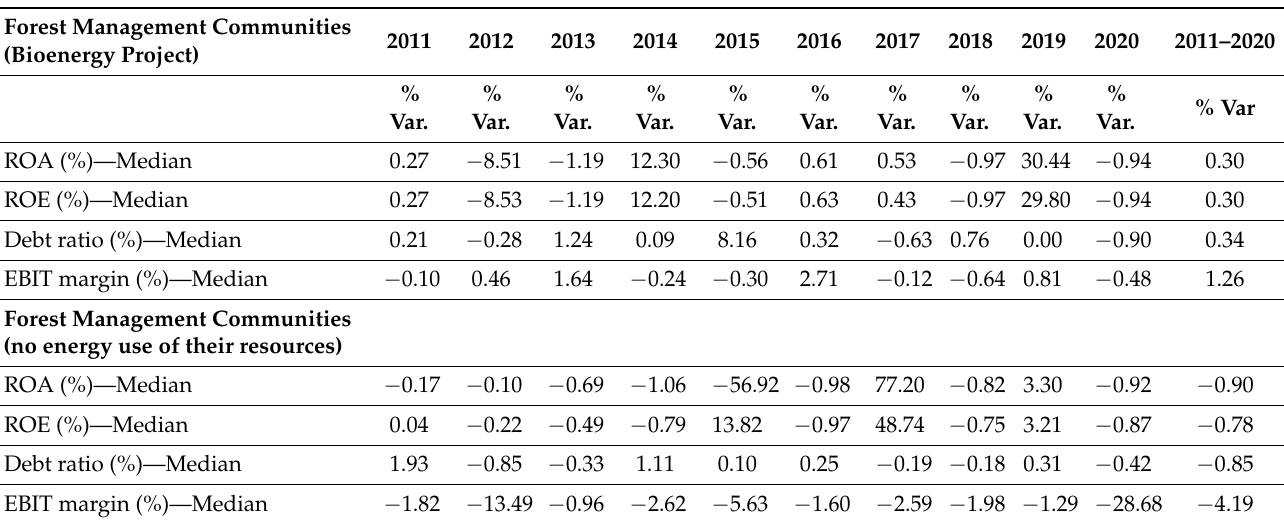
Table 5. Rates of change of the economic performance indicators of the two groups of forest manage- ment communities at the aggregate